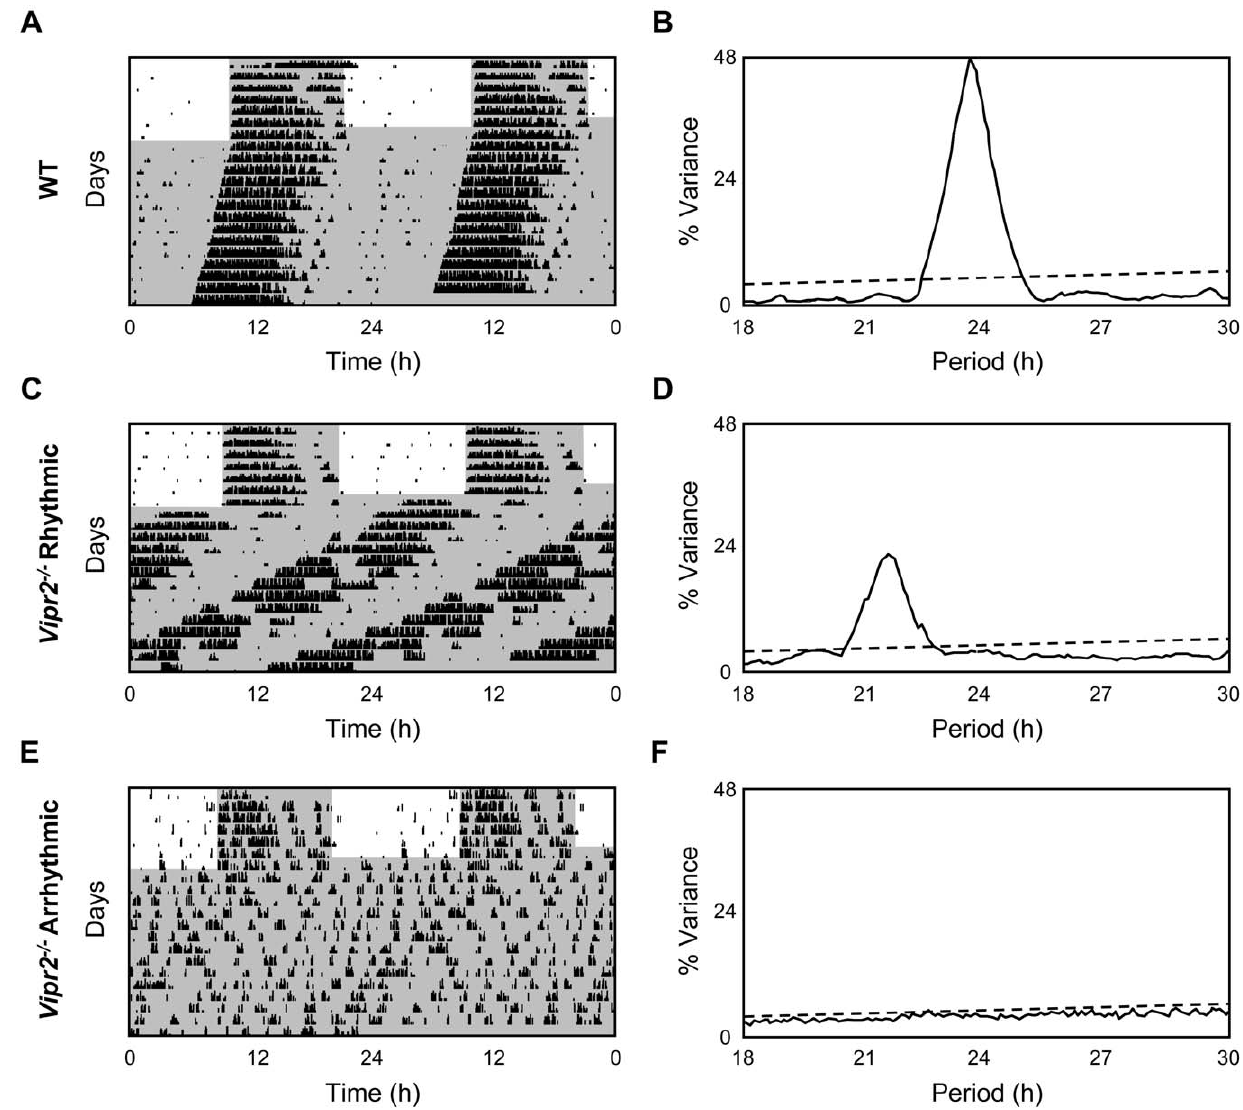
Figure 1. Representative Actograms and Periodograms for Individual WT and Vipr2 2 / 2 Mice Expressing the PER2::LUC Reporter. Both WT and Vipr2 2 / 2 PER2::LUC-expressing mice synchronize to an LD cycle ( A , C , E ). WT mice [expressing the PER2::LUC reporter] exhibit a strong, near 24 h, locomotor activity rhythm in DD, evident on the actogram ( A ) and from the corresponding high power periodogram peak at , 24 h ( B ). Activity recordings and periodograms from Vipr2 2 / 2 mice expressing the PER2::LUC reporter display a continuum of behavioral phenotypes in DD, from strongly rhythmic with a shortened behavioral period ( , 22.5 h; C – D ) to arrhythmic ( E – F ). Actograms are double-plotted, showing 2 days per row; shaded areas on actograms represent darkness. Peridograms depict period (hours; x axis) and strength of the rhythm (%V; y axis). Dashed line indicates p =0.001.